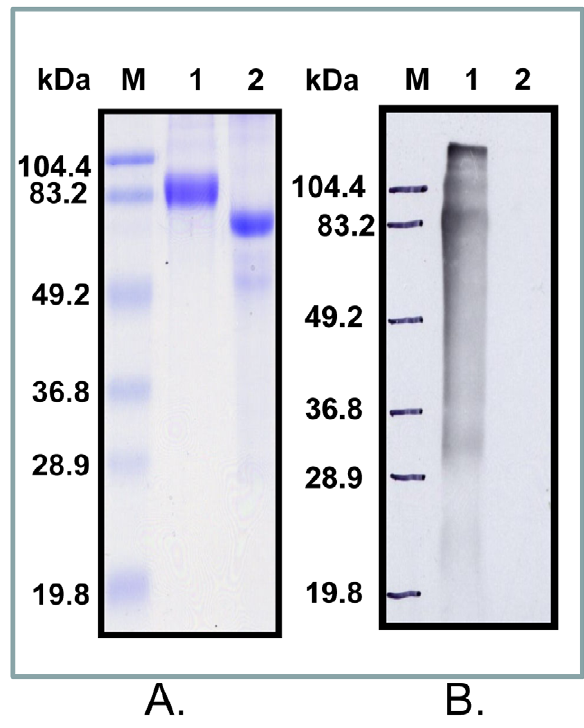
Figure 2. SDS-PAGE and Western blot of BSA-Hex and unconjugated BSA. A: Coomassie stained SDS-PAGE gel showing BSA-Hex, which contains 15.2 sugar residues per carrier, and unconjugated BSA, running at 81.4 kDa and 66.3 kDa, respectively. Lane M, standard molecular marker; lane 1, BSA-Hex; lane 2, BSA. B: Probe of BSA-Hex and BSA after transfer to nitrocellulose with MAb CS- 35 in a Western blot showing reactivity only with BSA-Hex.